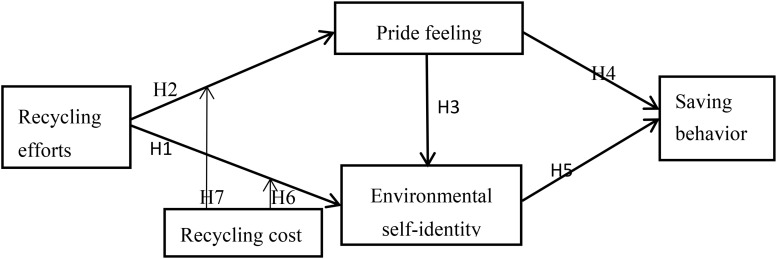
Conceptual model.